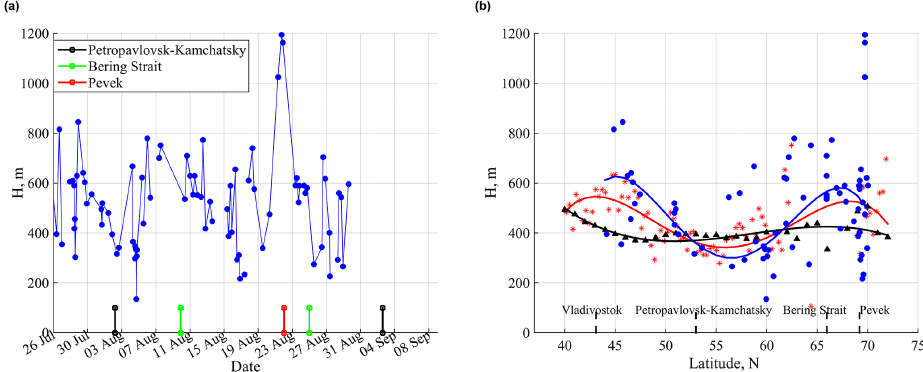
Figure 3. (a) The temporal behavior and (b) the latitudinal dependence of height H BL , calculated according to data of ship-based measure- ments (blue circles), CALIPSO satellite (red asterisks), and ECMWF reanalysis (black line with rectangles). Solid lines show polynomial fits of the latitudinal dependence of H BL